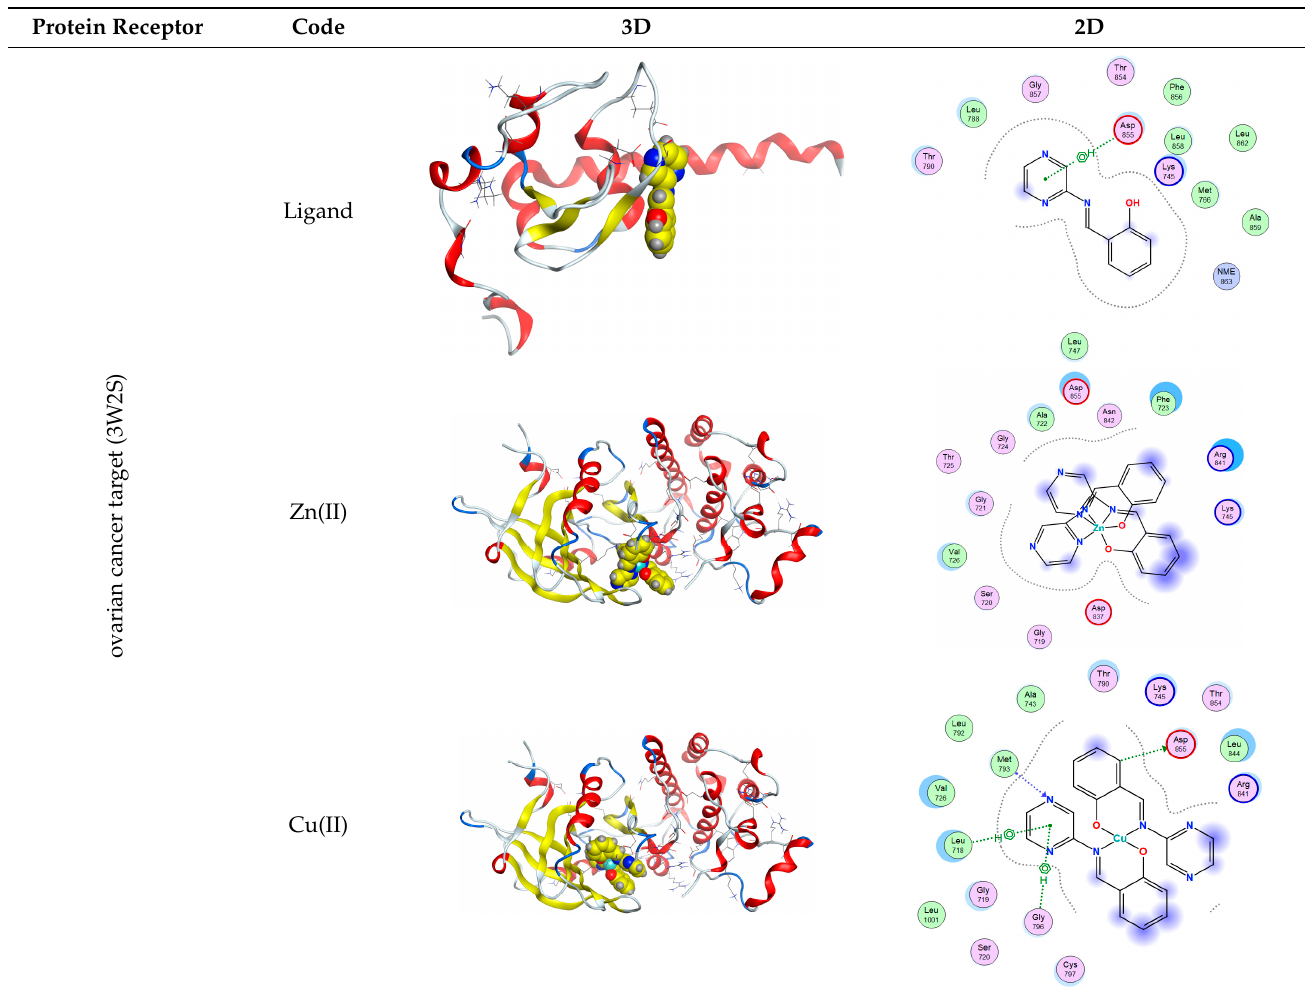
Table 5. The docking mode of the ligands and their metal complexes, 3D and 2D snapshot showing the hydrophilicity interaction to melanoma cancer target ( 2OPZ ) receptor, ovarian cancer target (3W2S) receptor and (NSCLC) cancer target (1S9J)